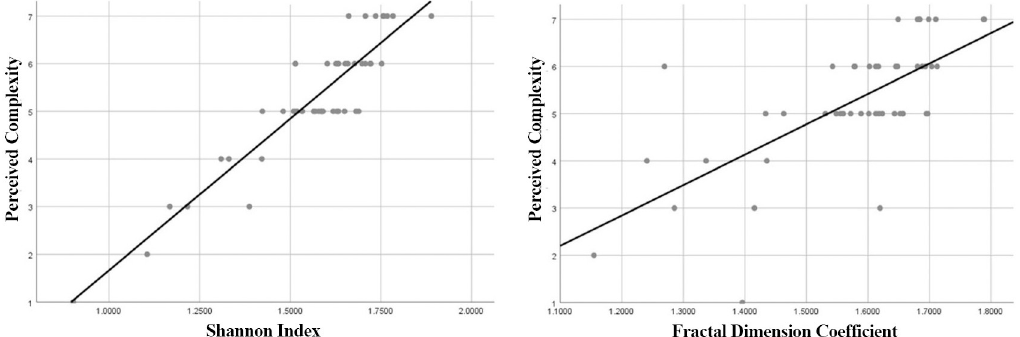
Fig 4. Linear relationship between the perceived complexity with Shannon Diversity Index (SDI) and fractal dimension